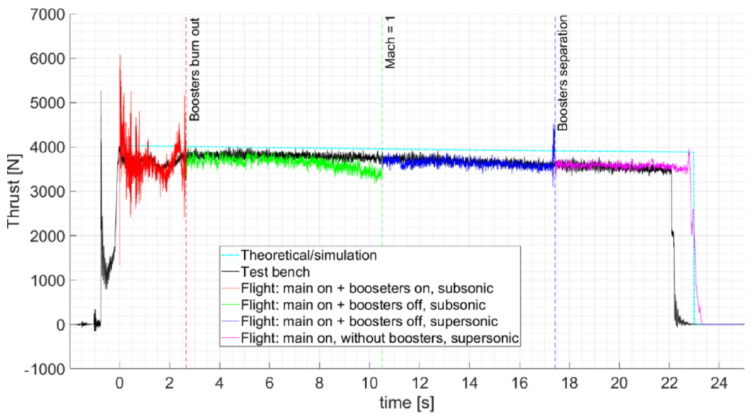
Figure 10. Performance of the hybrid rocket motor during flight and ground testing vs. initial simulation of the motor thrust curve, using data from thermochemical